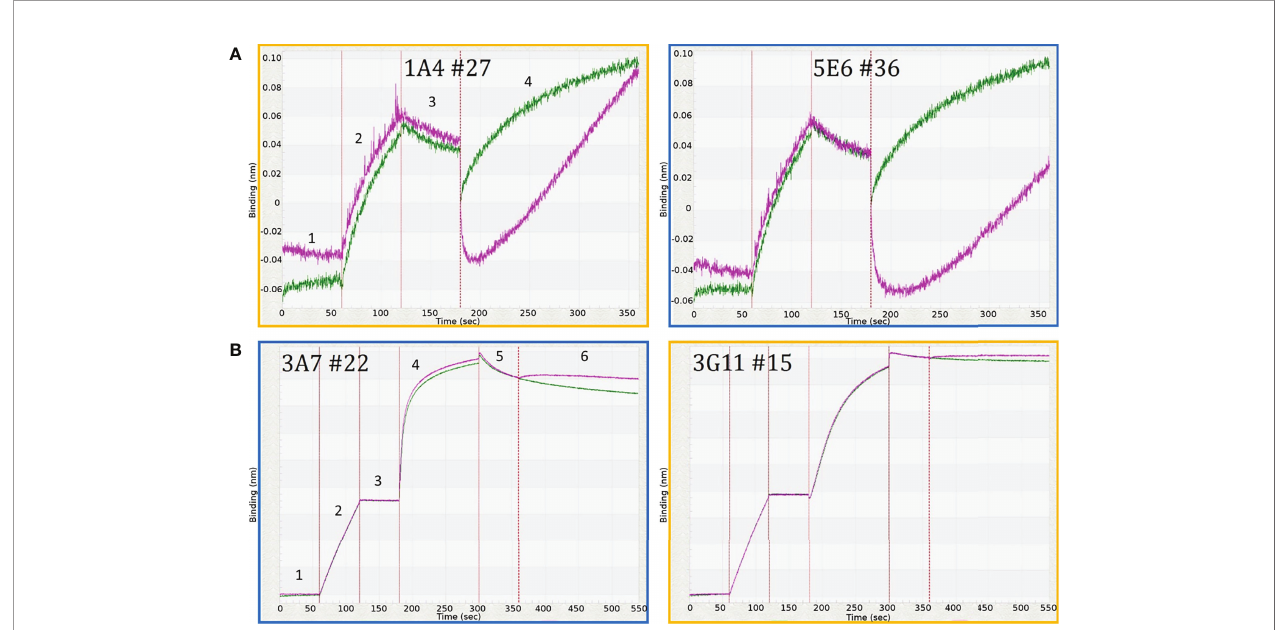
FIGURE 1 | Biolayer interferometry traces of crude hIgG1 clones showing different blocking pro fi les for (A) Pf RH5 clones 1A4#27 and 5E6#36; and (B) Pf CyRPA clones 3A7#22 and 3G11#15. For Pf RH5 (A) traces show cell culture supernatant containing only Pf RH5 recombinant hIgG1 antibodies (green) and cell culture supernatant containing both recombinant Pf RH5 ( r PfRH5) and recombinant human IgG1 antibodies (pink). Antibody 1A4#27 does not block Pf RH5 binding to Pf CyRPA. Conversely, antibody 5E6#39 blocks binding of Pf RH5 to Pf CyRPA (step 4). The numbered steps show 1) baseline for both sensors incubated in